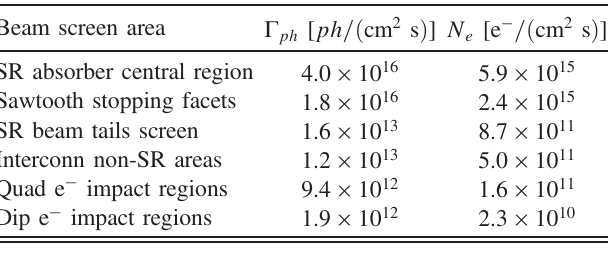
FIG. 8. Horizontal projection of the electron impingement rate inside the FCC-hh BS with a 16 T dipole magnetic field, depending on the SEY. 50 TeV, 500 mA, 25 ns beam. Inner chamber flat areas treated with LASE.